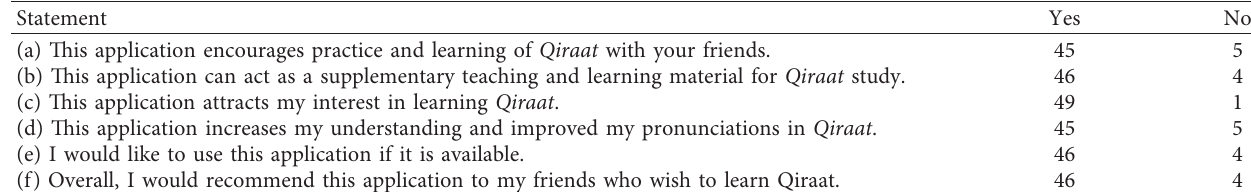
Table 4: Statement on research question